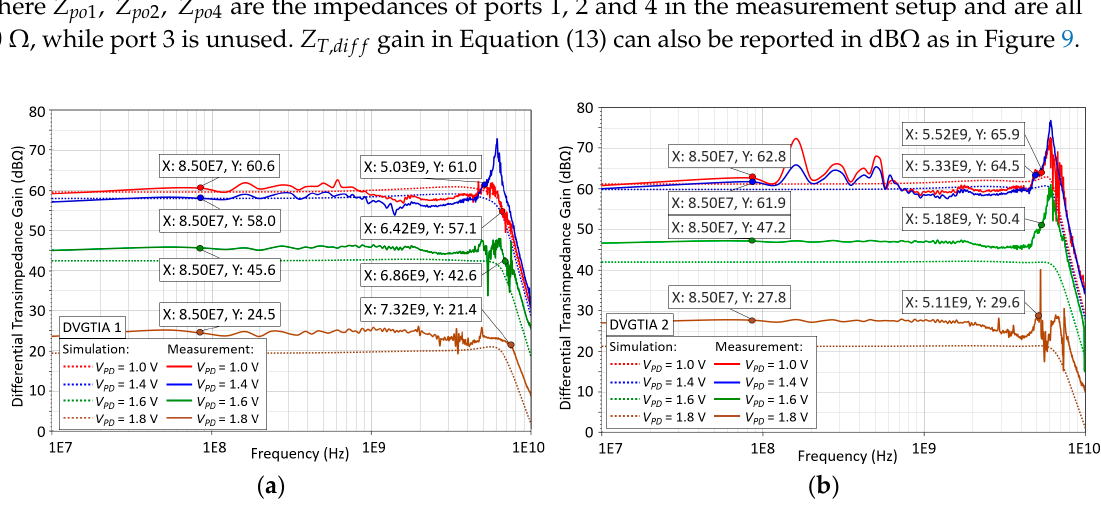
Figure 9. ( a ) Post-layout simulation and measured frequency response of the DVGTIA design 1 and ( b ) DVGTIA design 2 with varying V PD at 1 V, 1.4 V, 1.6 V and 1.8